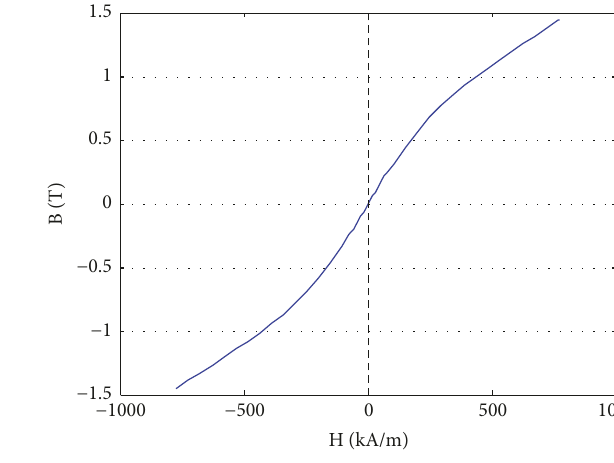
Figure 4: 𝐵 − 𝐻 curve of DT4C.